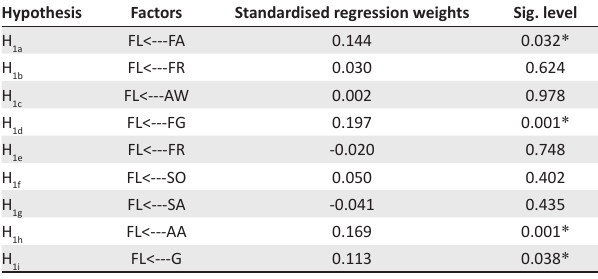
TABLE 4: Standardised regression weights, estimates and p -value. Hypothesis Factors Standardised regression weights Sig.